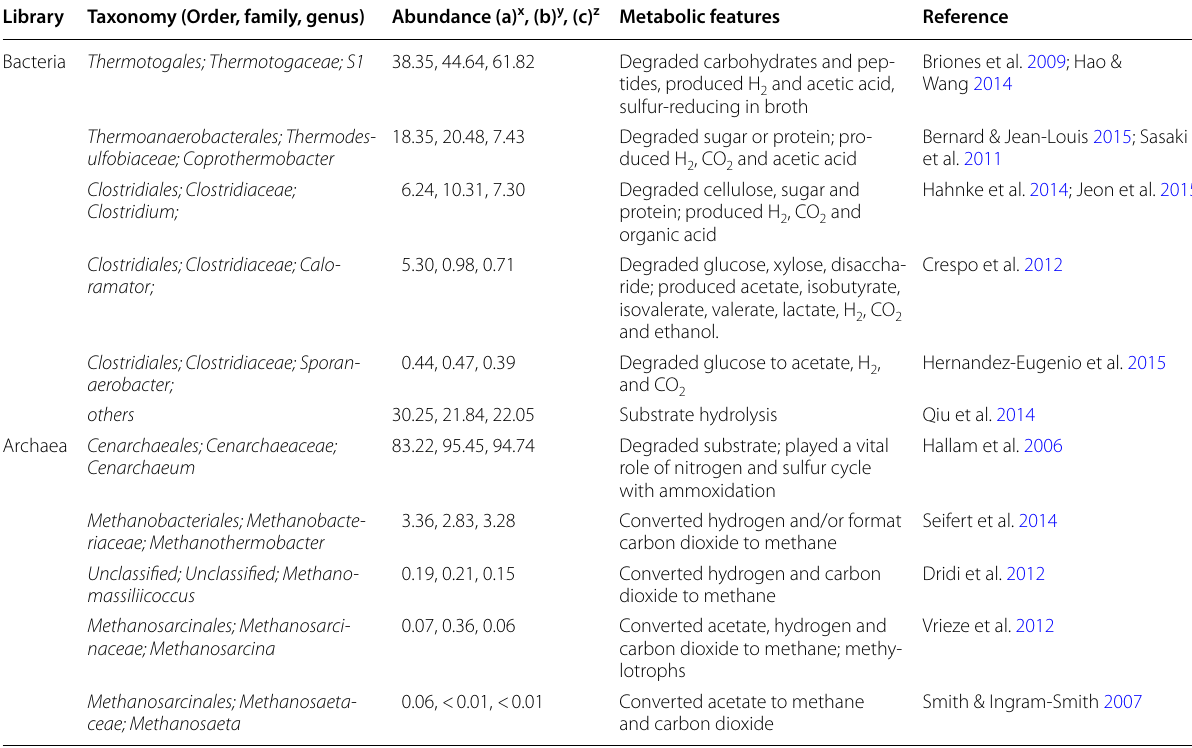
x Ranking of relative abundance within the Acidification phase . y Ranking of relative abundance within the Methanogenesis phase . z Ranking of relative abundance within the Degenerating phase